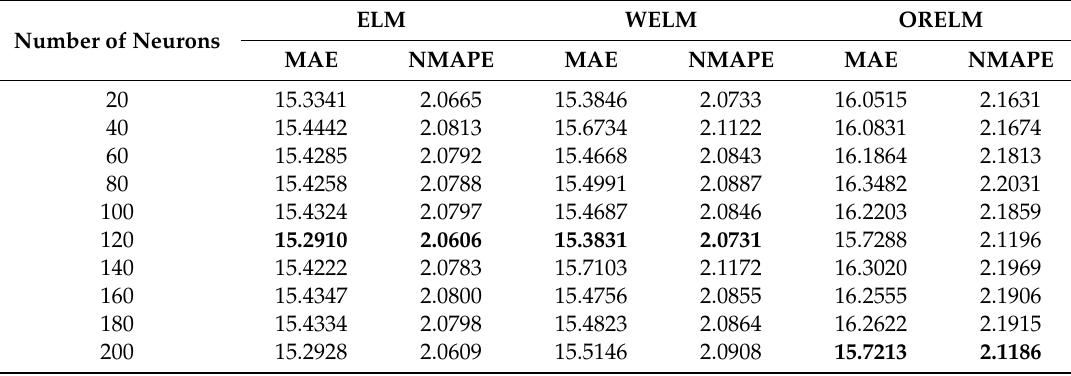
Table 6. Power curve modeling results of ELM-based models on validation set of Dataset